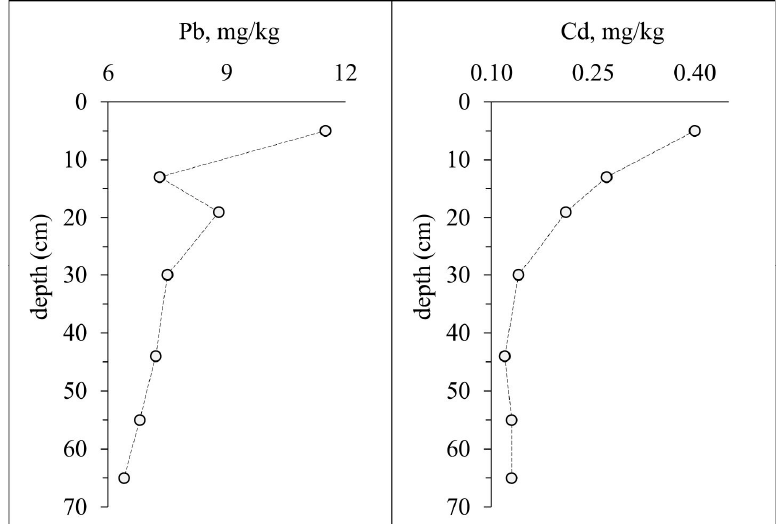
Figure 18. The vertical distribution of Pb and Cd in sediments of Lake Kotokel (Siberia) [104]. Conclusions of Section 3.3